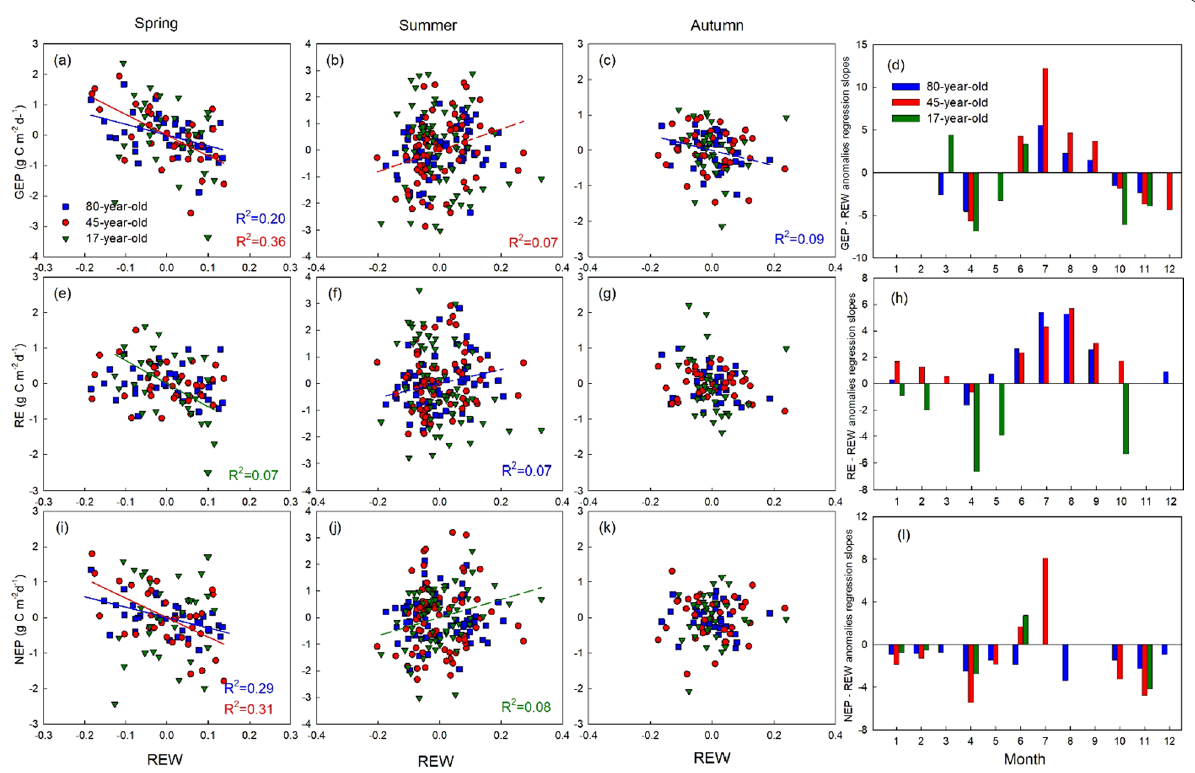
Fig. 5 Correlations between monthly relative extractable water (REW) anomalies and monthly gross ecosystem productivity (GEP) ( a – c ), ecosystem respiration (RE) ( e – g ), and net ecosystem productivity (NEP) ( i – k ) anomalies in spring (AM), summer (JJAS) and autumn (ON) in the 80‑, 45‑, and 17‑year‑old stands. Significant linear regressions at p < 0.01 are shown as solid lines. Significant linear regressions at 0.01 < p < 0.05 are shown as dashed lines. The slope of the linear relationship between daily REW anomalies and daily GEP ( d ), RE ( h ) and NEP ( l ) in each month are shown when the regression was significant at p <